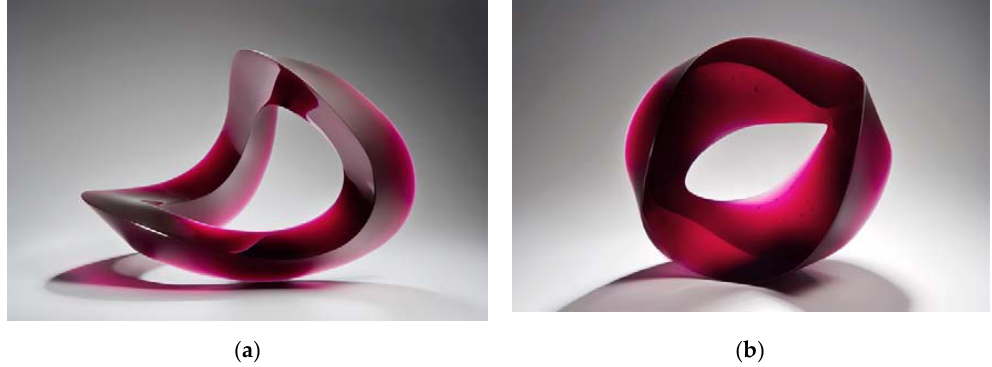
Figure 10. Bullseye 1931 ‐ 65 Ruby Pink Striker. Photographs by Ester Segarra, courtesy of the artist. ( a ) Heike Brachlow, Perihelion 2018, cast glass, 39 × 55 × 43 cm. ( b ) Heike Brachlow, Samoon 2018, cast glass, 34.5 × 35 × 32 cm.